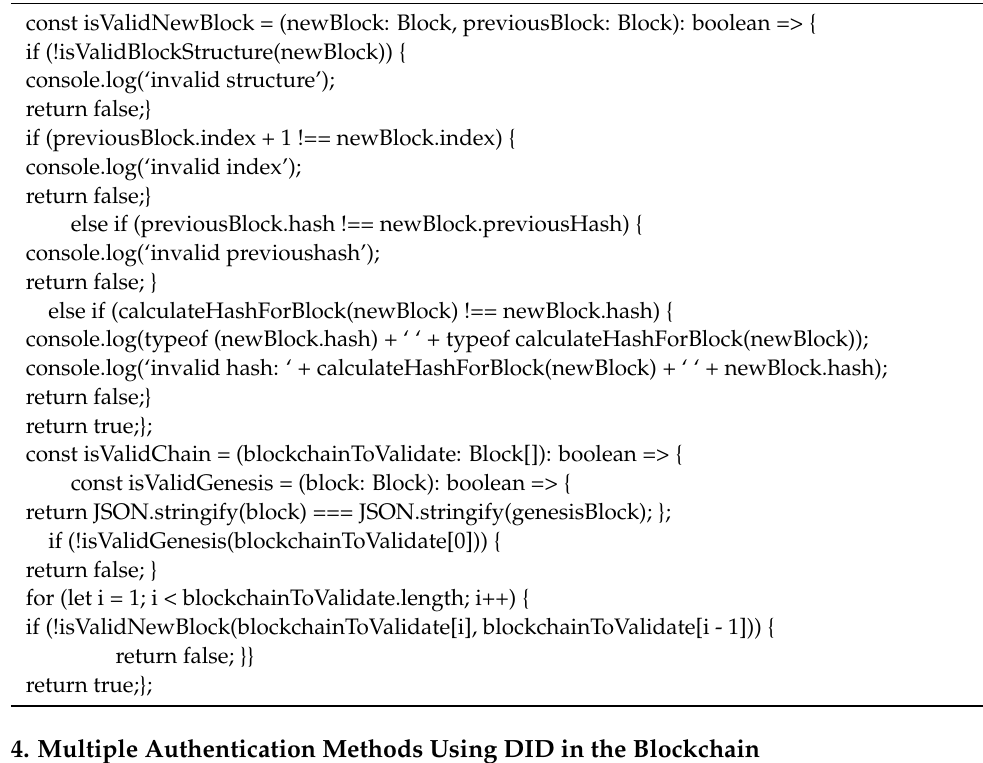
Algorithm 1 Blockchain Based Authentication